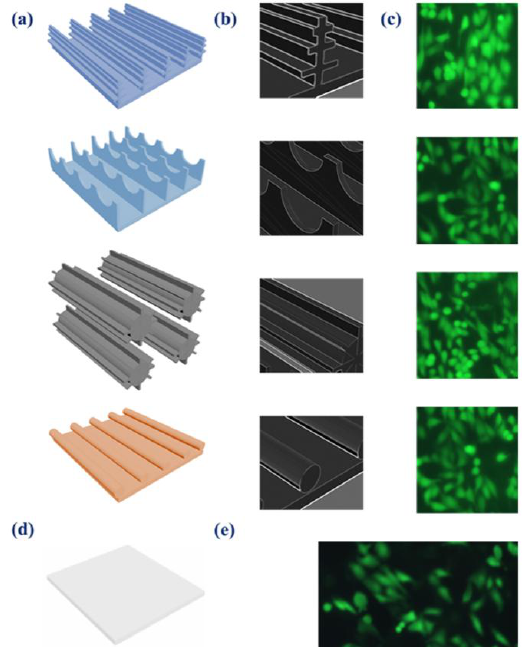
Figure 4. Aggregate formation on the selected natural anisotropic substrates. ( a ) Schematic of the anisotropic structures of the four substrates: M. menelaus , P. u. telegonus (blue area), P. u. telegonus (fibrous area), and O. c. lydius wings, from top to bottom, respectively. ( b ) Schematic focusing on the characteristic of the anisotropic structures of the four substrates: M. menelaus , P. u. telegonus (blue area), P. u. telegonus (fibrous area), and O. c. lydius wings, from top to bottom, respectively. ( c ) Fluorescence microscopy images of HepG2 cells cultured on different substrates after 48 h: M. menelaus , P. u. telegonus (blue area), P. u. telegonus (fibrous area), and O. c. lydius wings, from top to bottom, respectively. ( d ) Schematic of the culture dish surface. ( e ) Fluorescence microscopy image of HepG2 cells cultured on a culture dish.